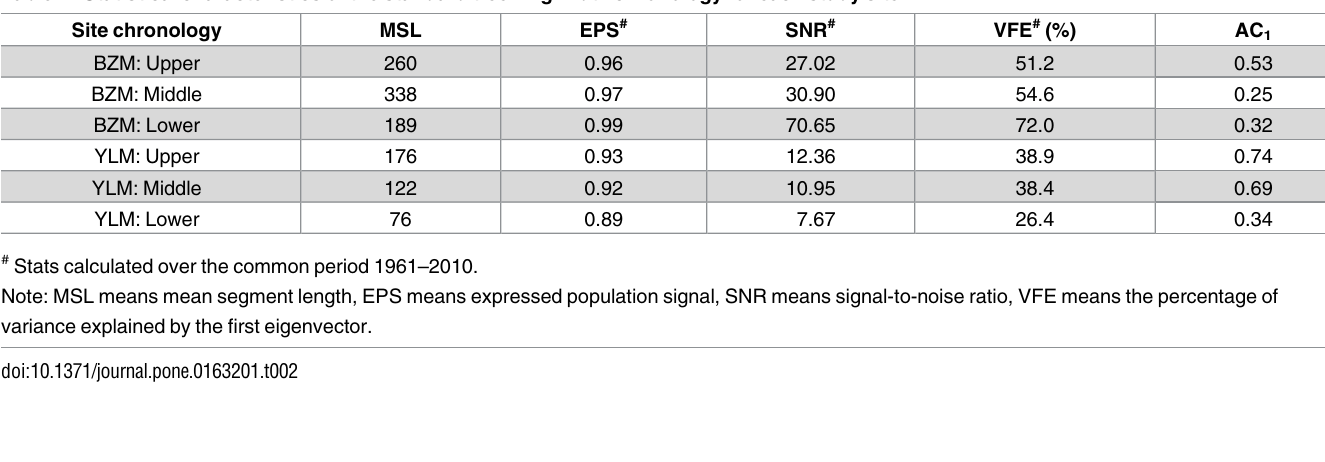
Table 2. Statistical characteristics of the standard tree-ring width chronology for each study